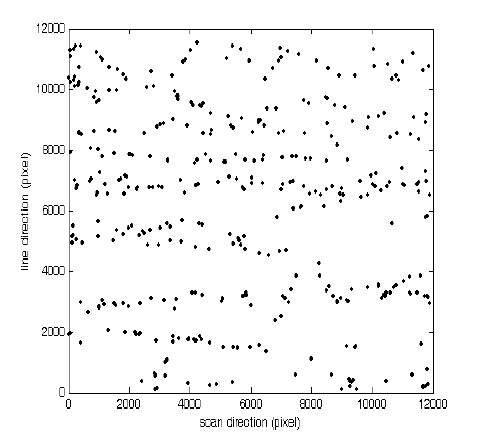
Figure 3: Distribution of the measured image points. In Fig. 3, ordinate represents the satellite flight direction referred to as the “line direction” and the abscissa indicates the line across the sensor detectors, referred to as “scan